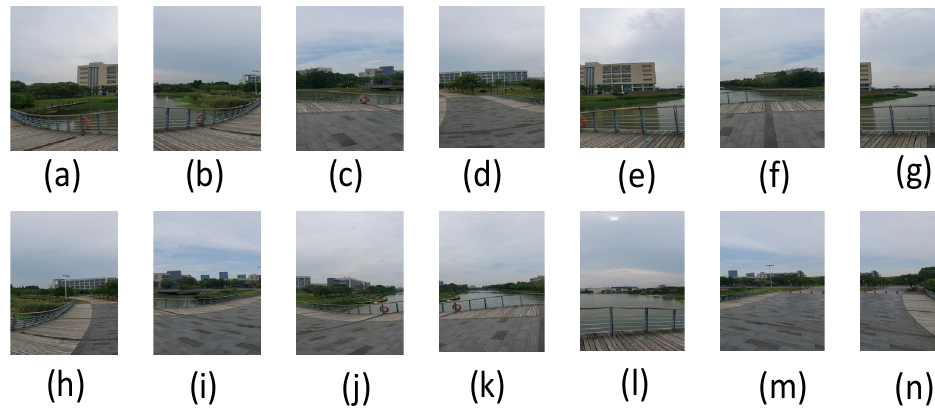
Figure 9. ( a – n ) are the experimental images of scene 2.